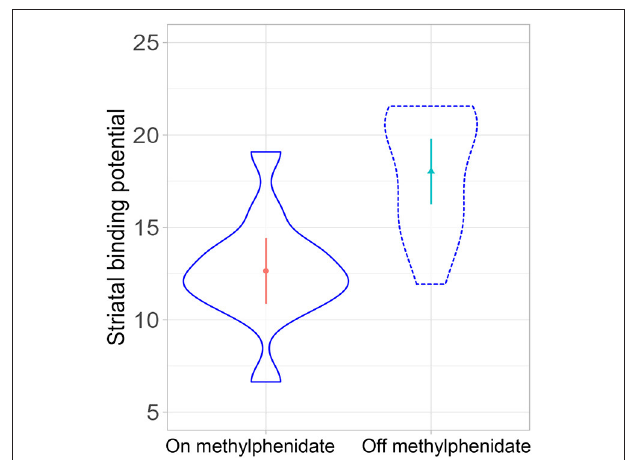
FIGURE 2 | Comparison of striatal dopamine transporter (DAT) binding potential on- and off-methylphenidate ( p = 0.002).